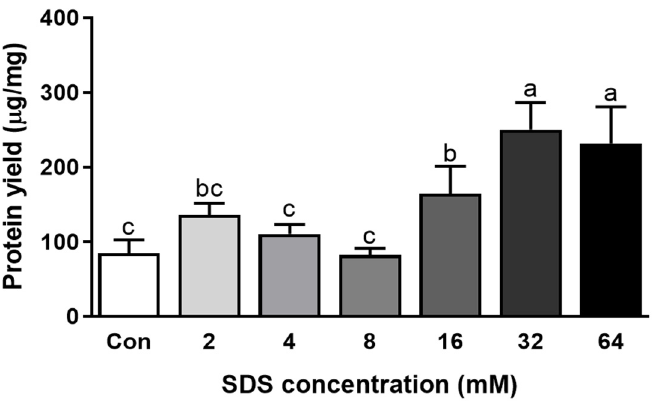
Figure 4. Protein extraction yield with different concentrations of SDS with 0.6 M NaCl in phosphate buffer with EDTA. Bars with different letters are significantly different ( p < 0.05).